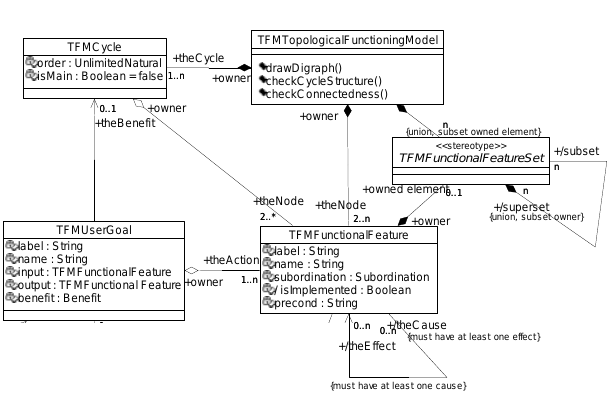
Fig. 1. The fragment of TFM metamodel